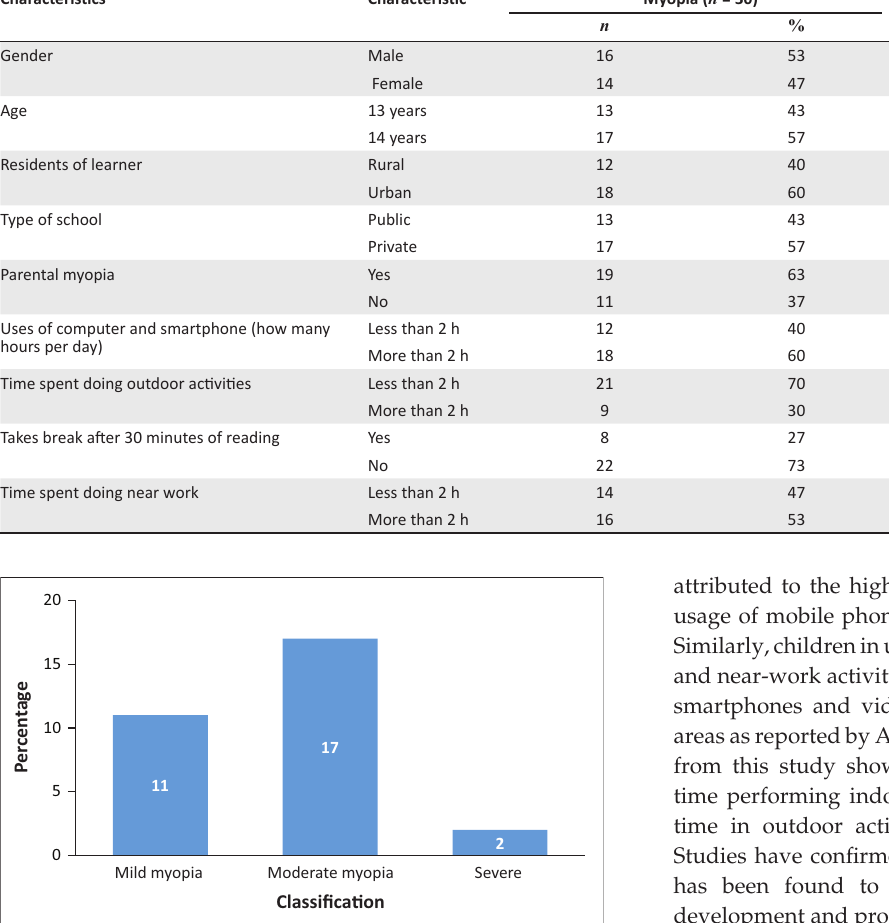
TABLE 2: The prevalence of myopia and its association with the factors studied. Characteristics Characteristic